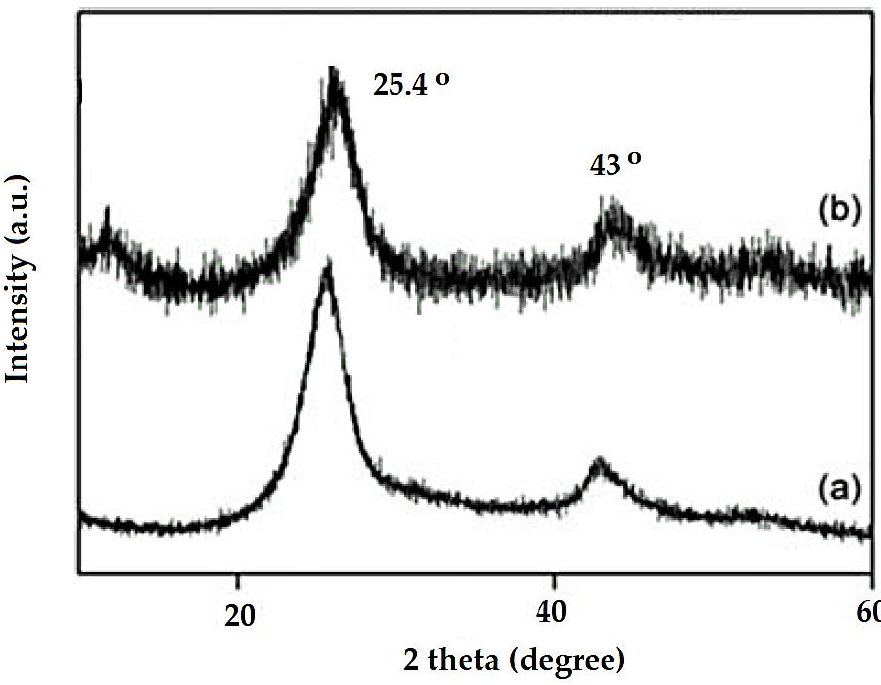
Figure 4. XRD pattern of (a), MWCNTs – CO 2 H and (b),